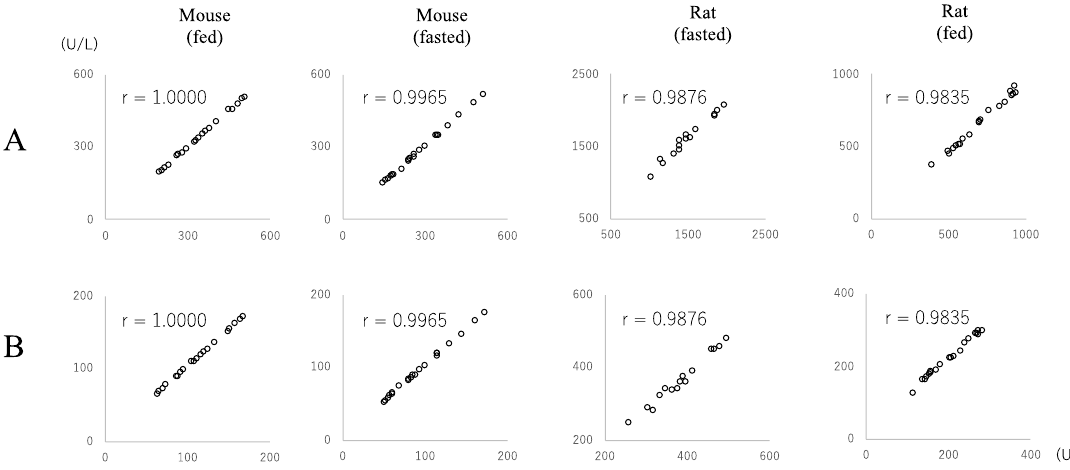
Figure 7. Scatter plots of the measured ALP values (x-axis) and estimated ALP values (y-axis) using the conversion factors. ( A ): Measured IFCC ALP values (x) and estimated IFCC ALP values (y) obtained from the JSCC values using the conversion factors. ( B ): Measured JSCC ALP values (x) and estimated JSCC ALP values (y) obtained from the IFCC values using the conversion factors.